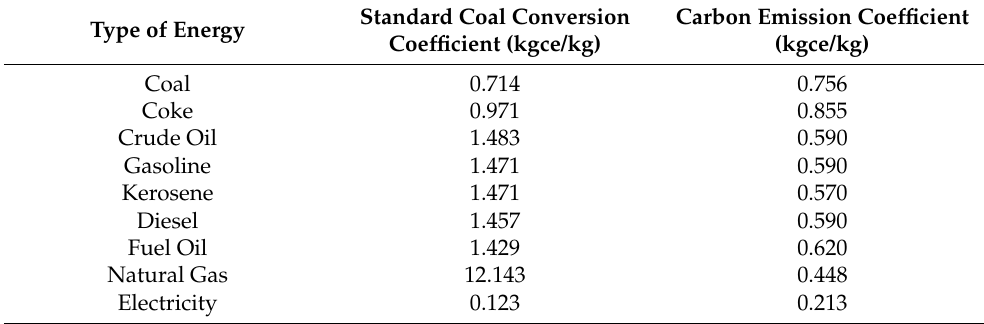
Table 1. Standard Coal Conversion Coefficient and Carbon Emission Coefficient of Different Energy Types. Standard Coal Conversion Carbon Emission Coefficient Type of Energy Coefficient (kgce/kg) (kgce/kg) Coal 0.714 0.756 Coke